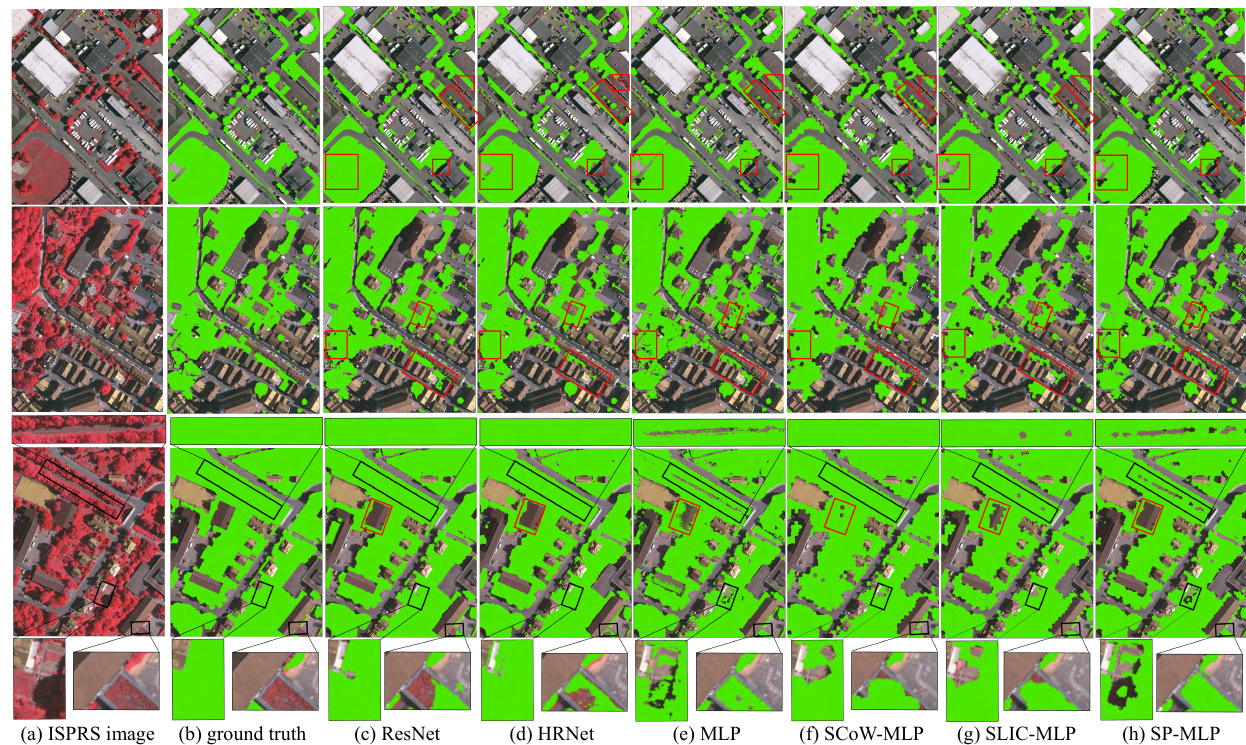
Figure 7 . Three ISPRS original images and v egetation extraction